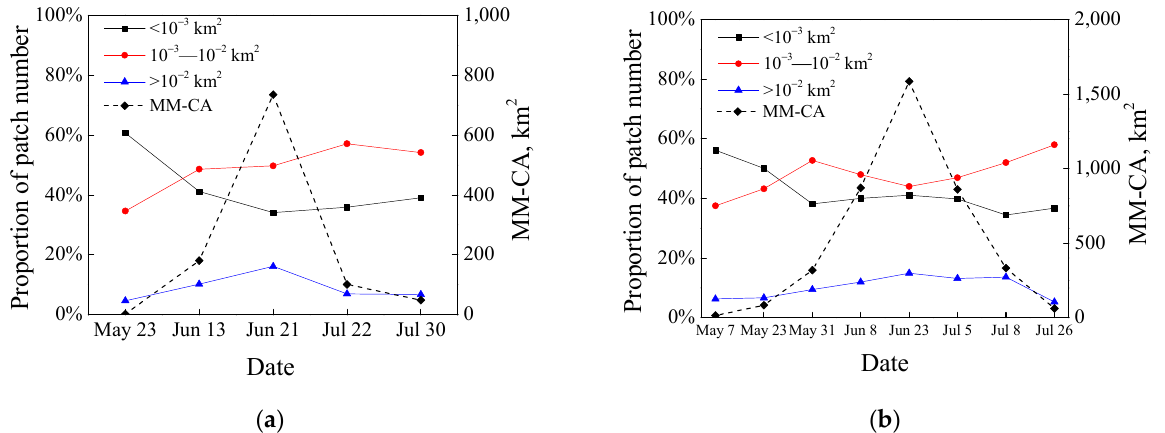
Figure 8. Changes of proportion of patch number and MM-CA of macroalgae in different periods. ( a ) GF WFV images in 2018. ( b ) GF WFV images in